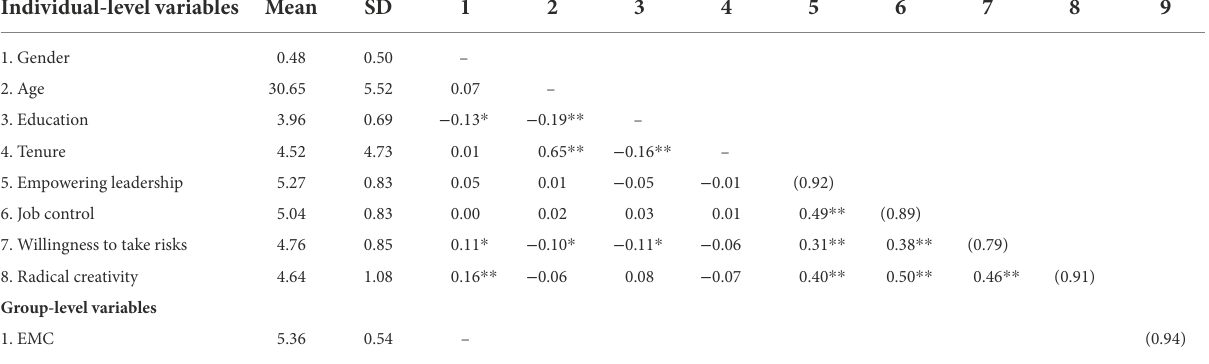
TABLE 1 Means, standard deviations, correlations, and reliabilities.